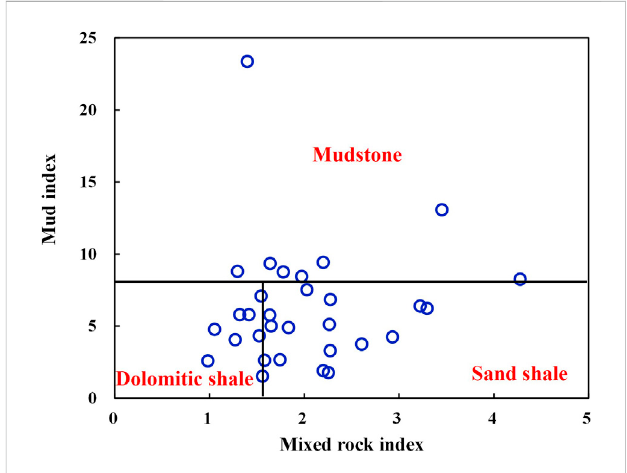
Shale oil reservoir type classi fi cation